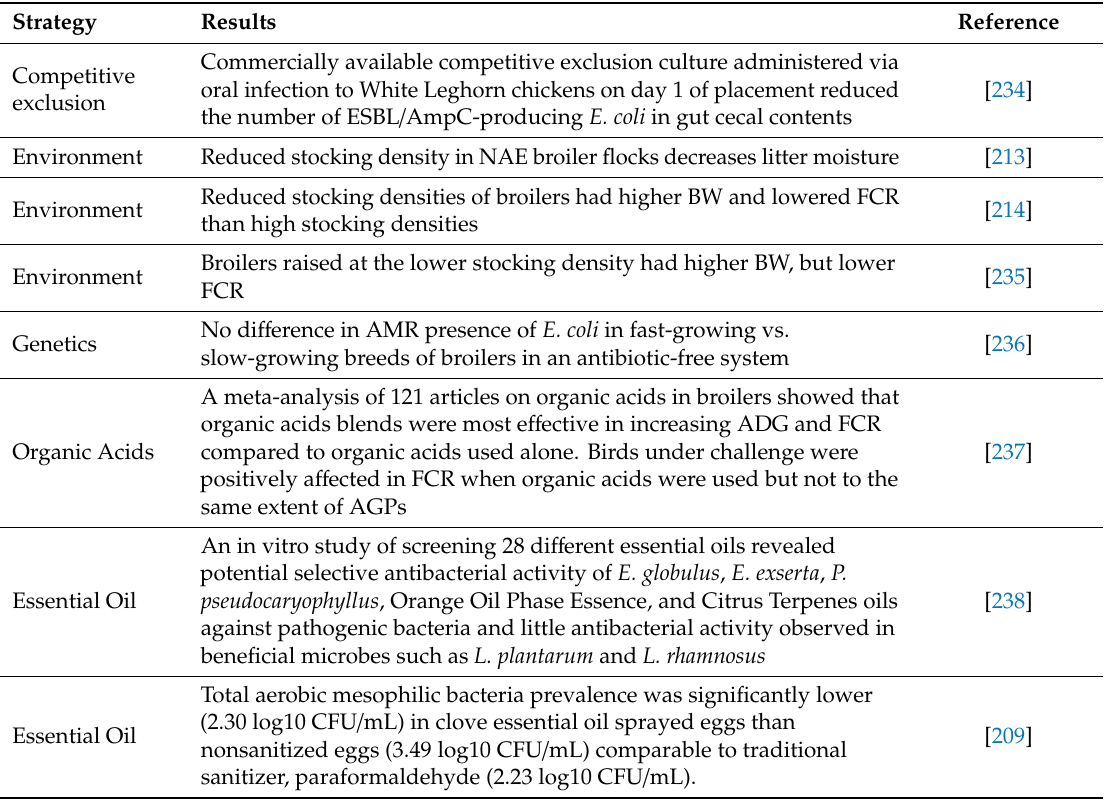
Table 3. Other preventative strategies and antibiotic alternative e ff ects in broiler